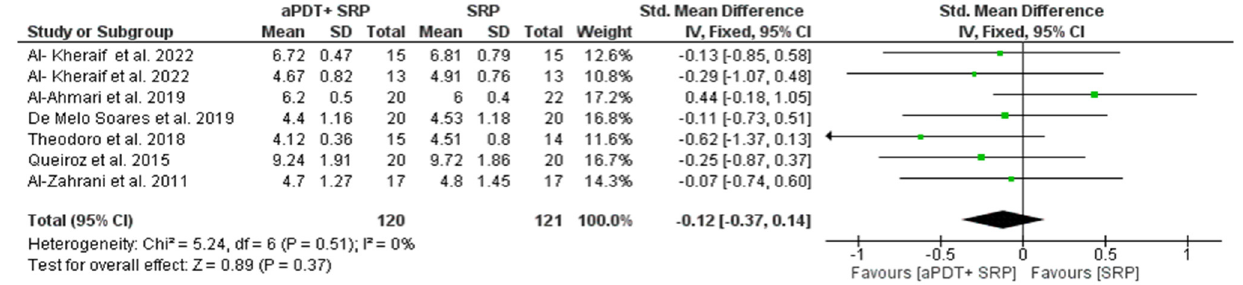
Figure 4. Forest plot of CAL gain at 3 month.